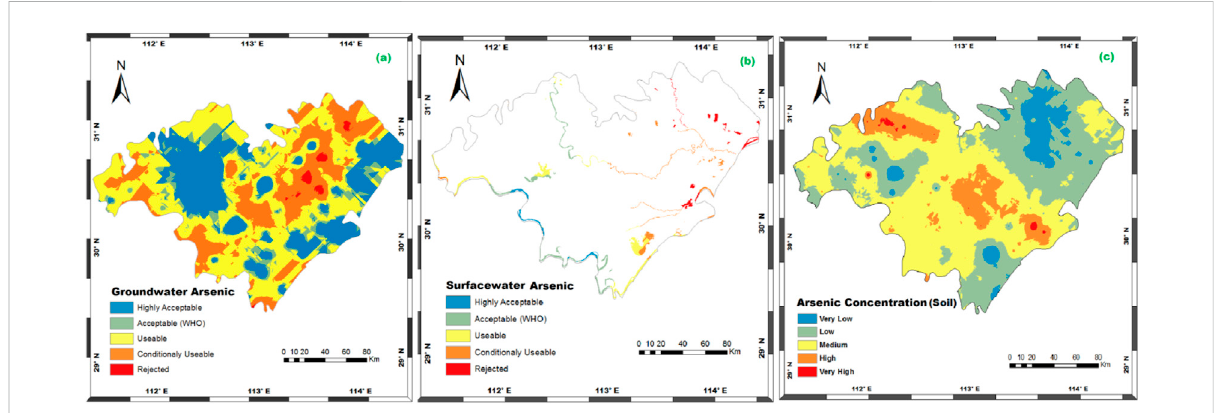
FIGURE 2 Arsenic distributions in the (A) groundwater (GW), (B) surface water (SW), and (C) soil in Jianghan